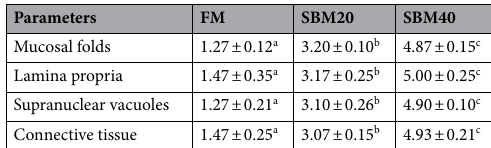
Table 2. Semi-quantitative histological evaluation of intestinal sections (n =